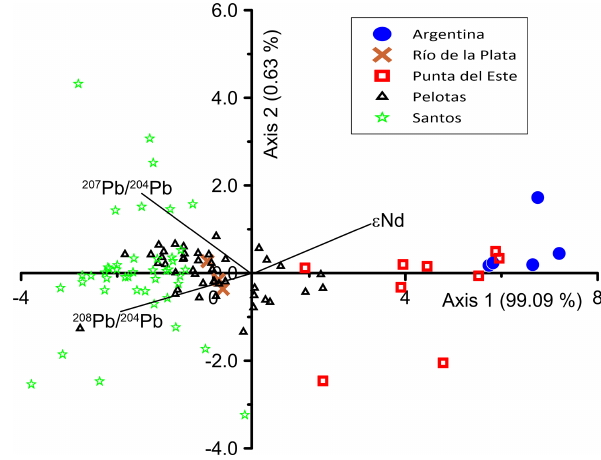
Figure 4. Scatter plot of the samples according to the first two axes generated from the discriminant